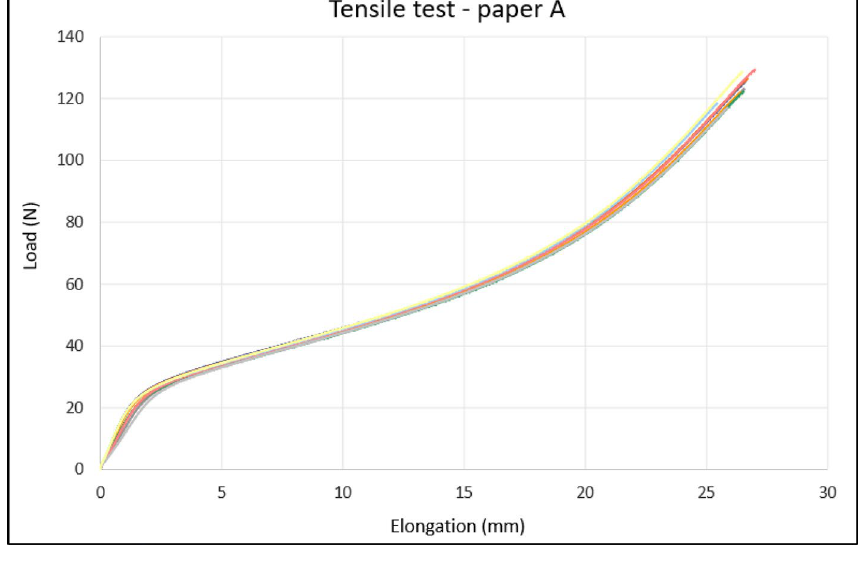
Fig. 25 Force elongation curves of individual specimen of paper